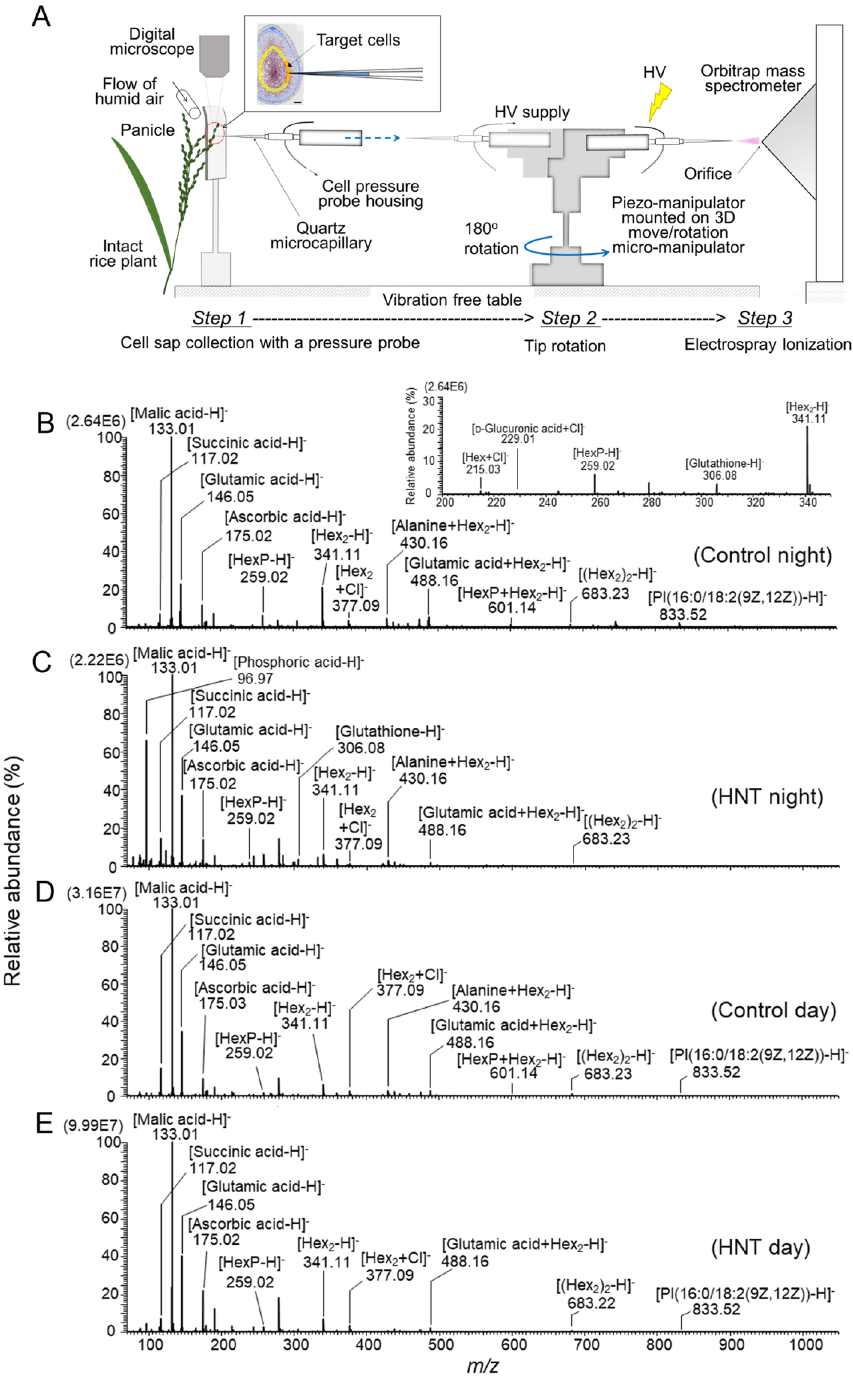
Figure 3. ( A ) Schematic diagram showing the flow from on-site cell metabolomics conducted in the rice endosperm cells growing under controlled environments. After cell sap collection using a cell pressure probe (Step 1), the tip was immediately rotated (Step 2) and then picoPPESI-MS was performed under the same environements (Step 3) (also see “Methods” section). Scale bar in the transverse section embedded in A is 200 μm. ( B–E ) Negative ion picoPPESI mass spectra obtained from the cells in control and HNT treatment at 9 DAH daytime and nighttime. Inset figure in B indicates magnified range of m/z 200–350 to show peaks of [Hex + Cl] − , [d-Glucuronic acid + Cl] − , [HexP-H] − , [Glutathione-H] − , and [Hex 2 -H] − . The data are representative of repeated experiments with 9–14 kernels in each